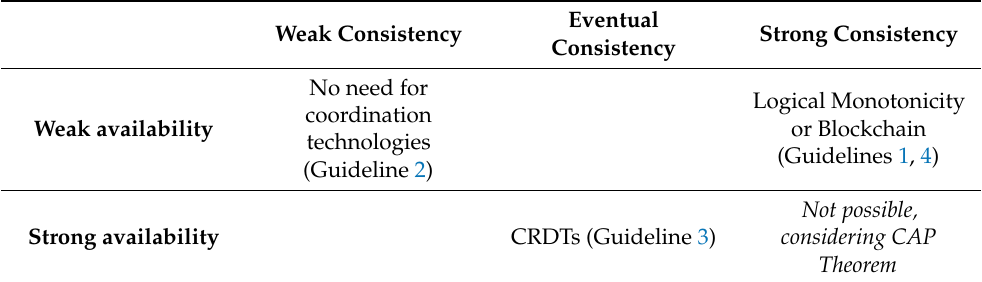
Table 1. Guidelines